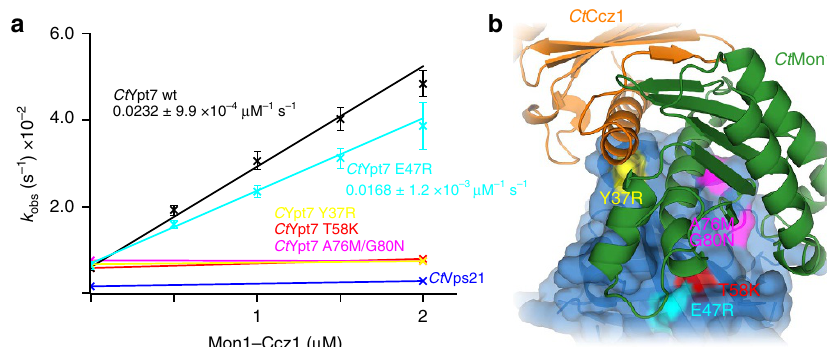
Figure 3 | Selectivity of Mon1–Ccz1 for Ypt7 over Vps21. ( a ) For Ct Vps21, Ct Ypt7 and different mutations, nucleotide exchange rates are plotted as a function of Ct MC1core concentration. Error bars represent s.d. of three independent biological repeats. ( b ) MC1-interacting interface of Ypt7 is shown in blue. Positions that are conserved in the Ypt7 family, but not the Vps21 family, are highlighted. Labels show the mutations from Ypt7- to Vps21-specific residues. Colours correspond to the graphs in b